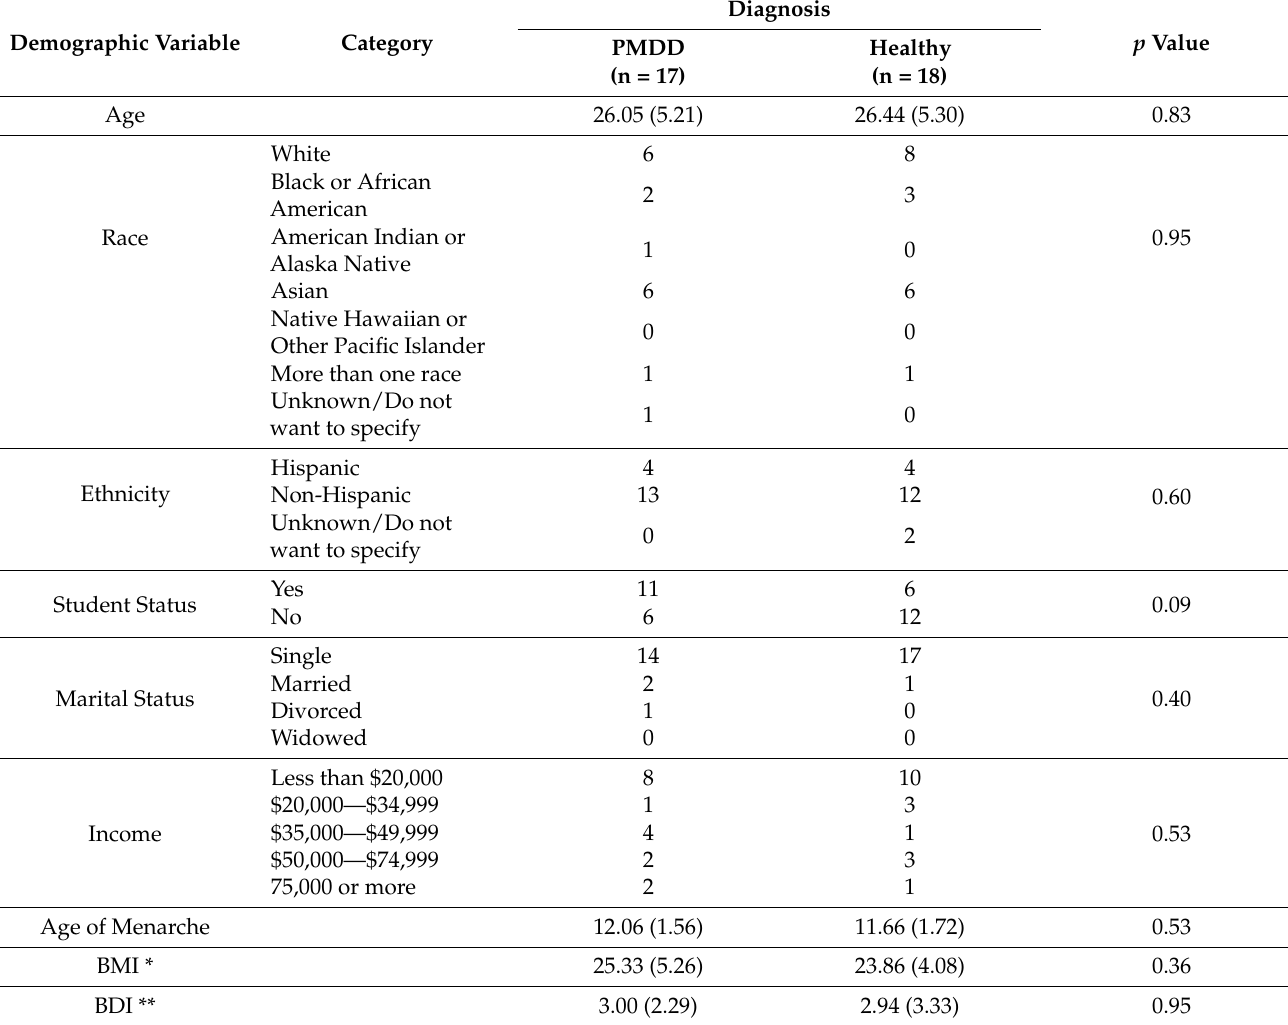
Table 1. Demographic characteristics according to study groups.